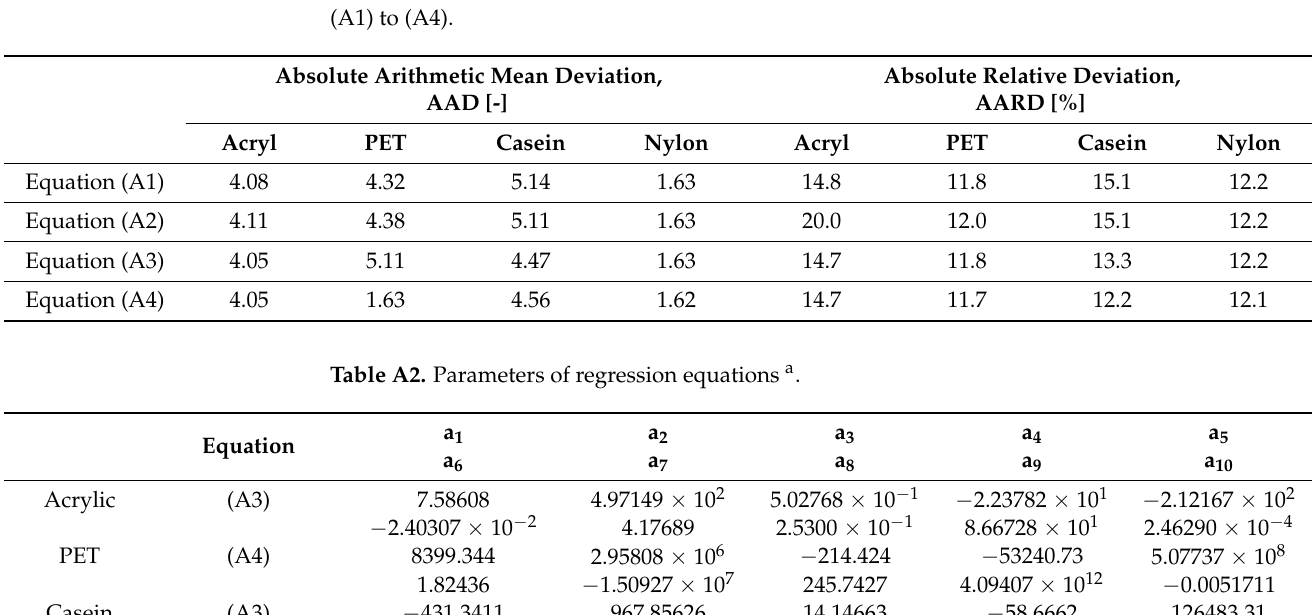
Table A1. Absolute arithmetic mean deviation and relative mean deviation for K / S by Equations